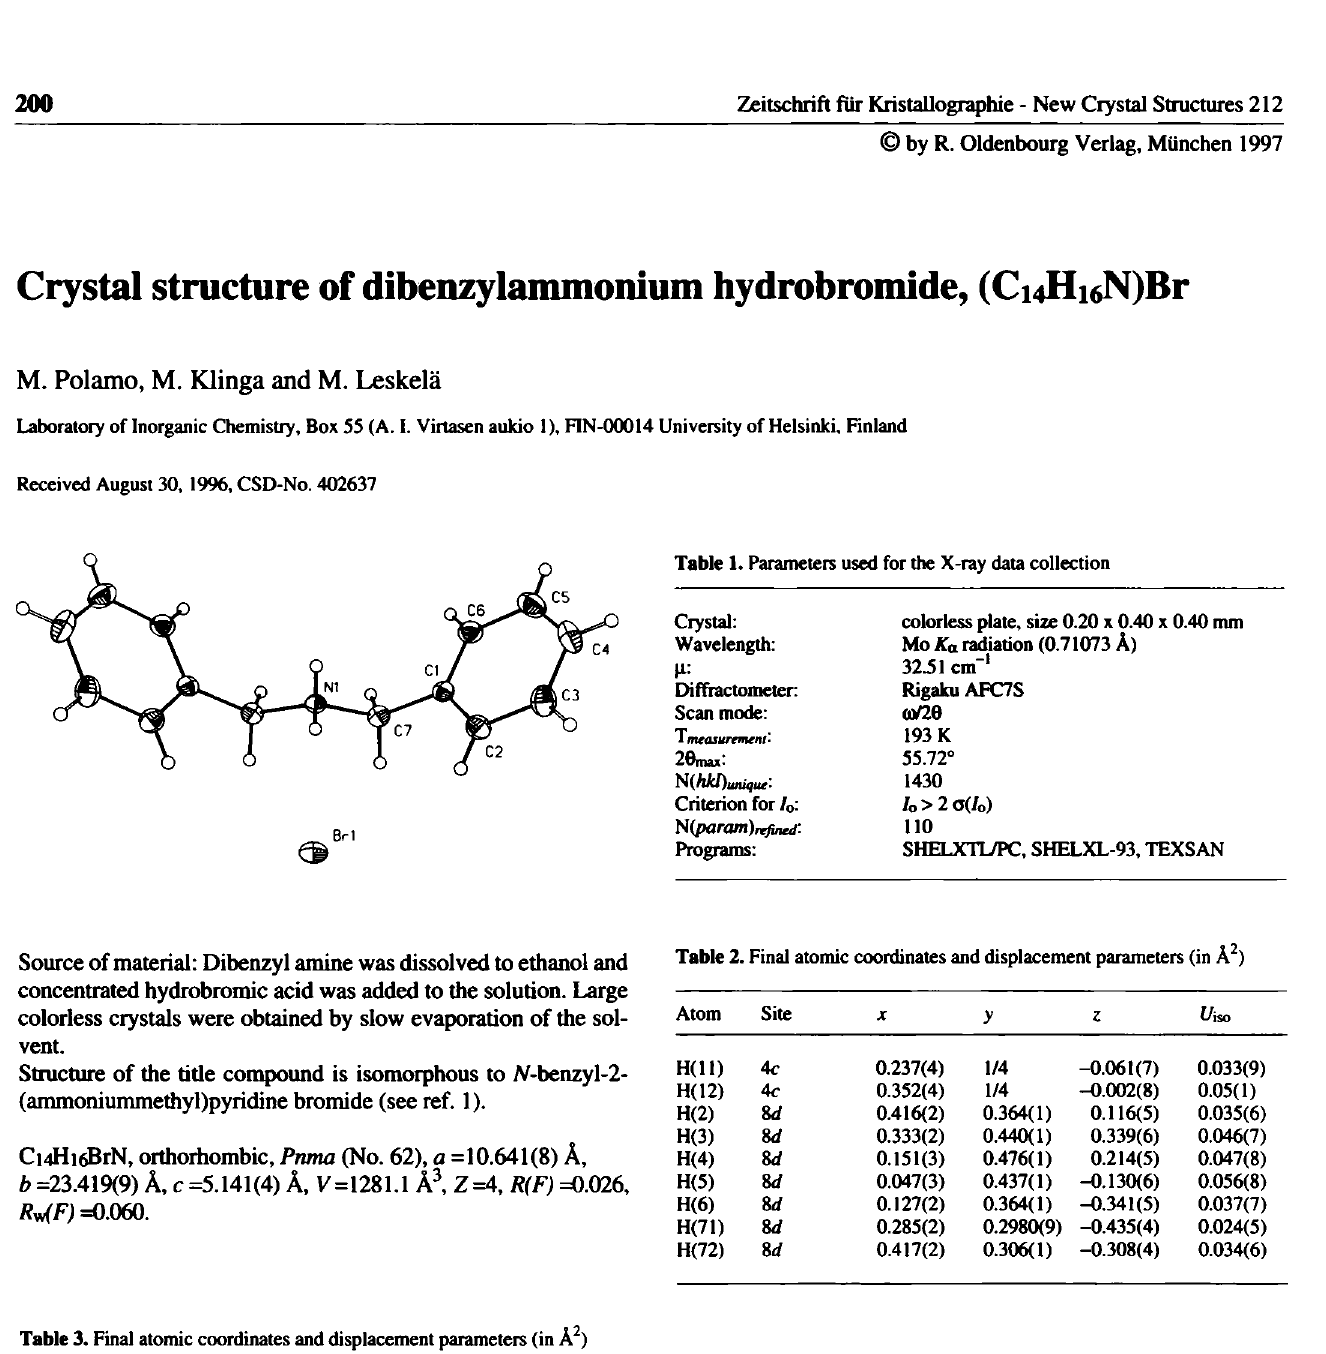
Table 3. Final atomic coordinates and displacement parameters (in Ä 2